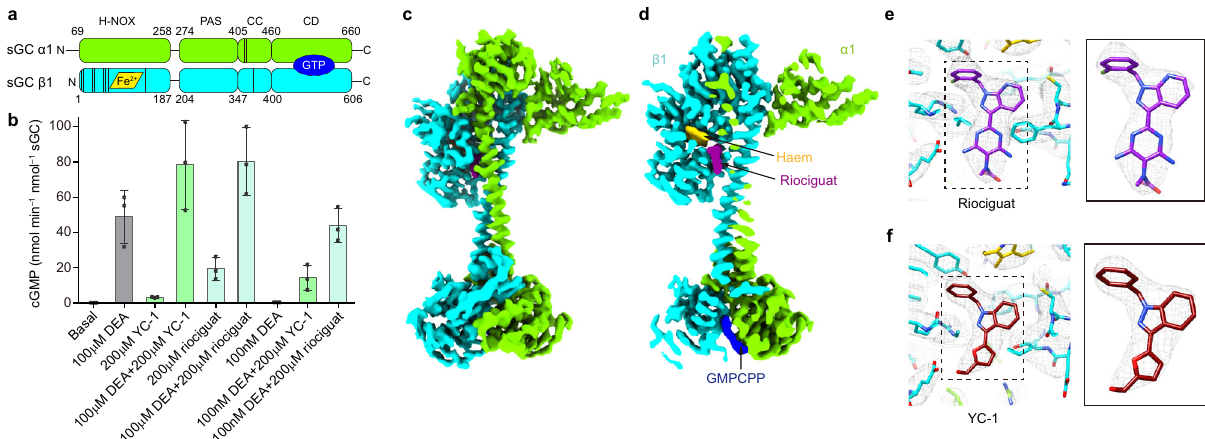
Fig. 1 Cryo-EM structure of sGC in the presence of NO and stimulators. a Domain organization of the human α 1 β 1 sGC heterodimer. The haem cofactor and the GTP substrate-binding site are shown in yellow and blue, respectively. The positions of residues interacting with riociguat are indicated with vertical dark lines. b End-point activity assay of wild-type sGC in the presence or absence of DEA, YC-1, or riociguat as indicated. Mean ± s.d., n = 3 biologically independent reactions. Source data are provided as a Source Data fi le. c Cryo-EM map of sGC in complex with NO and riociguat. The densities of haem, riociguat, and GMPCPP are shown in yellow, purple, and blue, respectively. d The cut-open view of ( c ). e Density at the riociguat – binding site. The map is shown as a gray mesh and atomic model is shown as sticks. f Density at the YC-1 – binding site. The map is shown as a gray mesh and atomic model is shown as